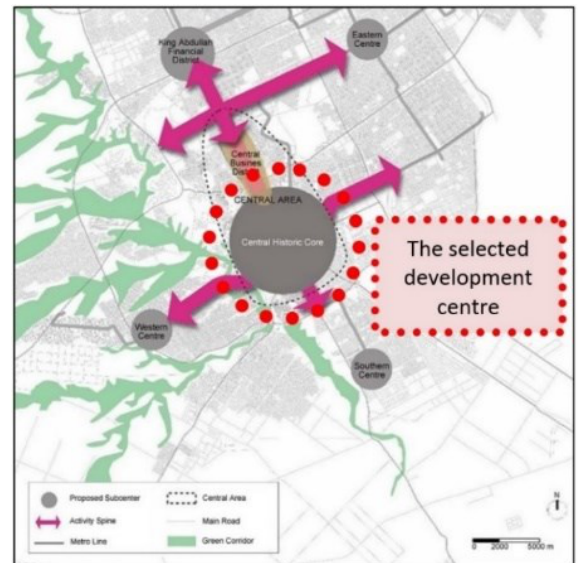
Figure 7. Transit-Oriented Development TOD strategy in the Riyadh metropolitan area (ADA,